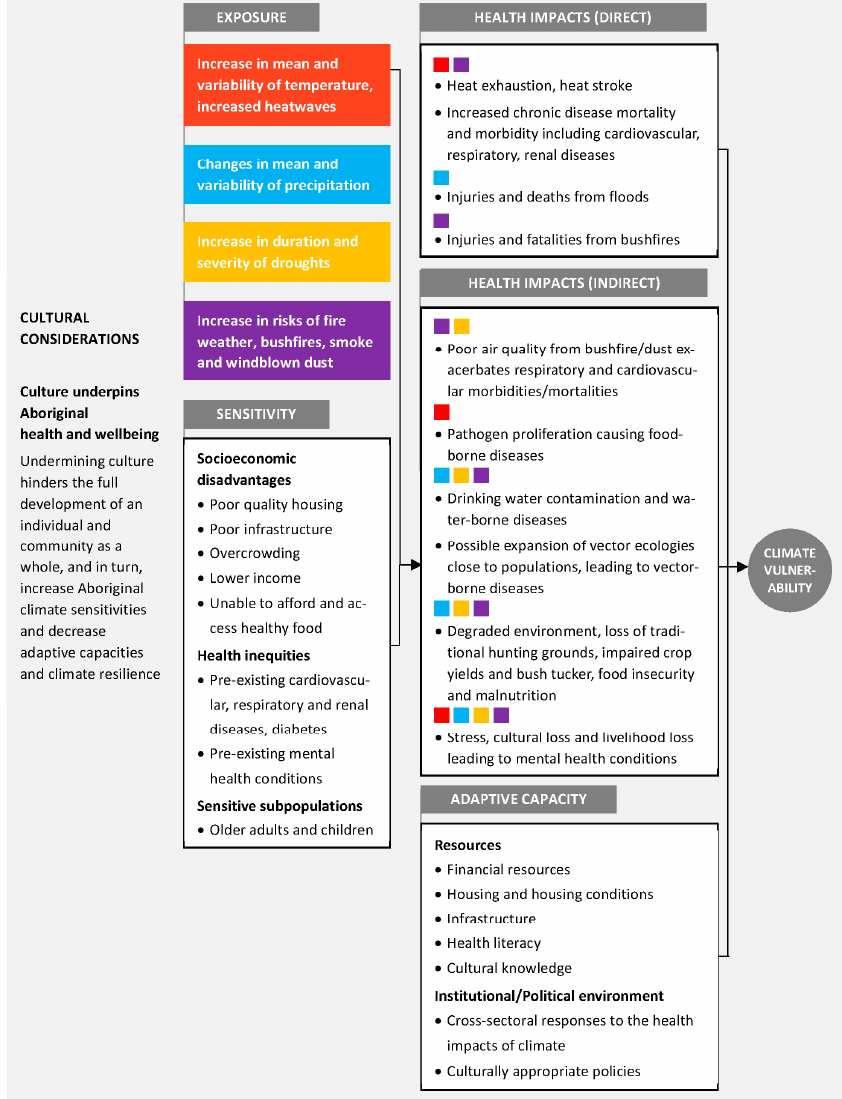
Figure 4. Summary of the components of climate vulnerability, where exposure to climate-related hazards and sensitivity factors contribute to the susceptibility of Aboriginal people to a range of direct and indirect health outcomes. Capacity to manage the influence of exposure and sensitivities to climate-related hazards can reduce the net vulnerability to climate change. (Adapted from [67]). Underpinning the components of climate vulnerability are the complex and important cultural de- terminants [68] of Aboriginal health and